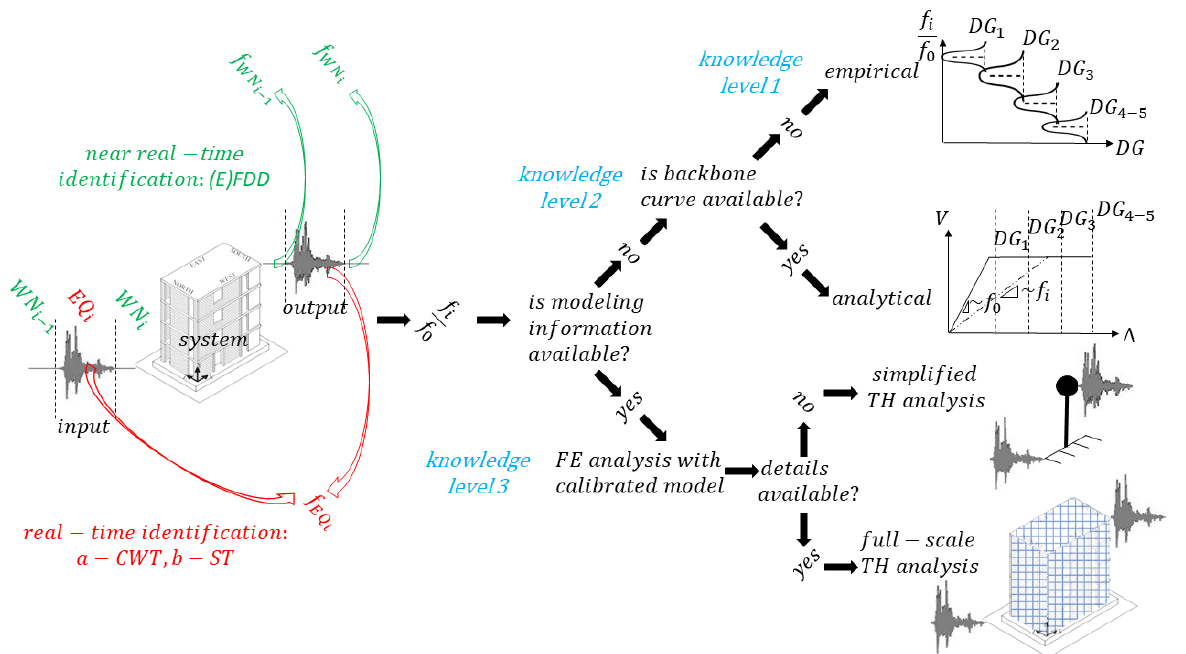
Figure 16. Proposed flowchart for knowledge level ‐ compatible damage assessment methodology.